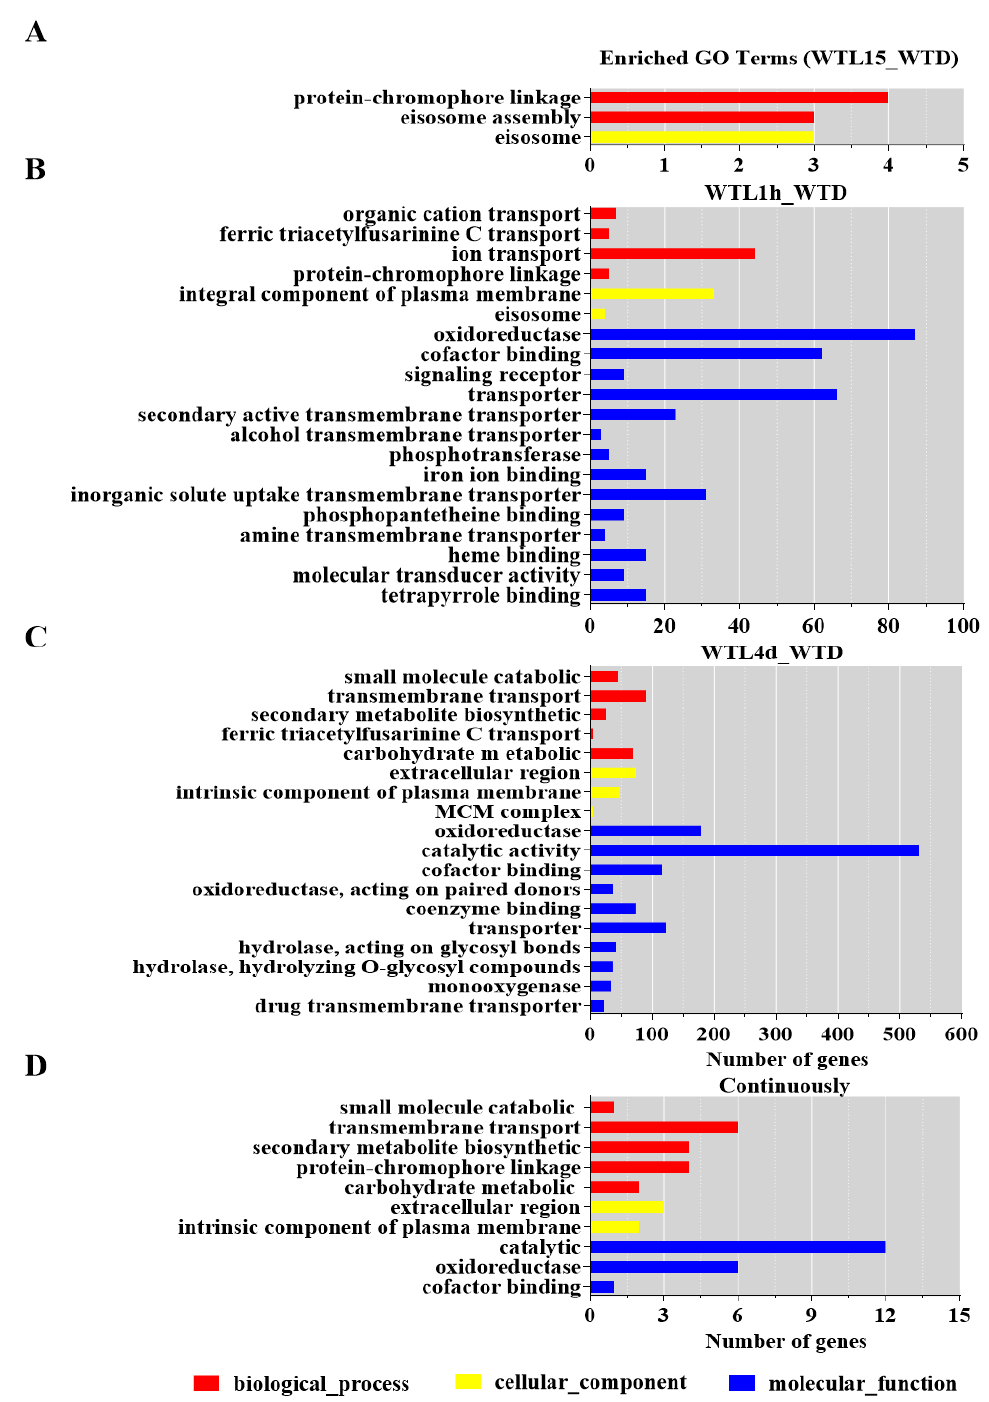
Figure 3. GO functional classification of differentially expressed genes. Enriched GO terms of immediate-early light-responsive genes ( A ), early light-responsive genes ( B ), late light-responsive genes ( C ), and continuous light-responsive genes ( D ). The significantly enriched GO terms (FDR < 0.05) removed redundancy using REVIGO were shown.